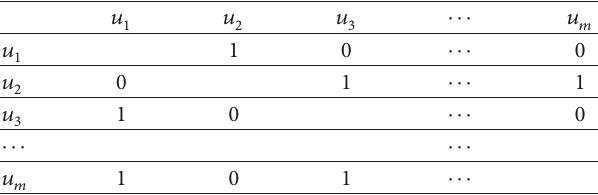
Table 2: The pairwise comparison matrix of an expert. Table 3: The pairwise comparison matrix of all experts.